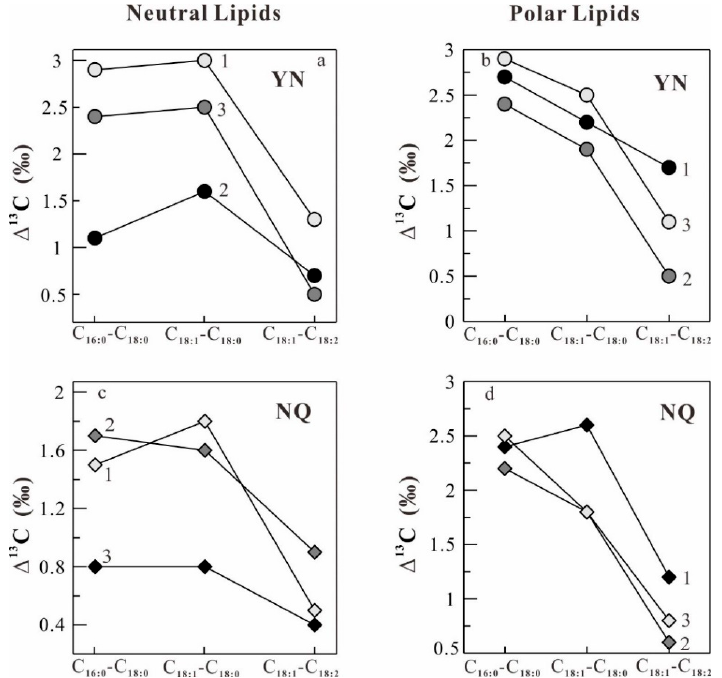
Figure 6. Difference of the δ 13 C values of major fatty acids ( Δ 13 C) between the samples from Yunnan (YN, ( a ) and ( b )) and Naqu (NQ, ( c ) and ( d )). ( a , c ) and ( b , d ) refer to neutral and polar lipids, respectively.